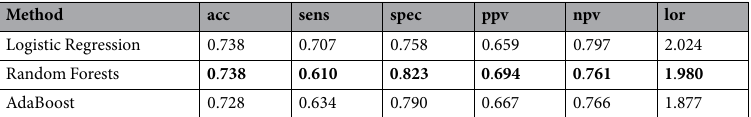
Table 25. Performance of prediction for TD/PIGD class label on Tel-Aviv dataset.